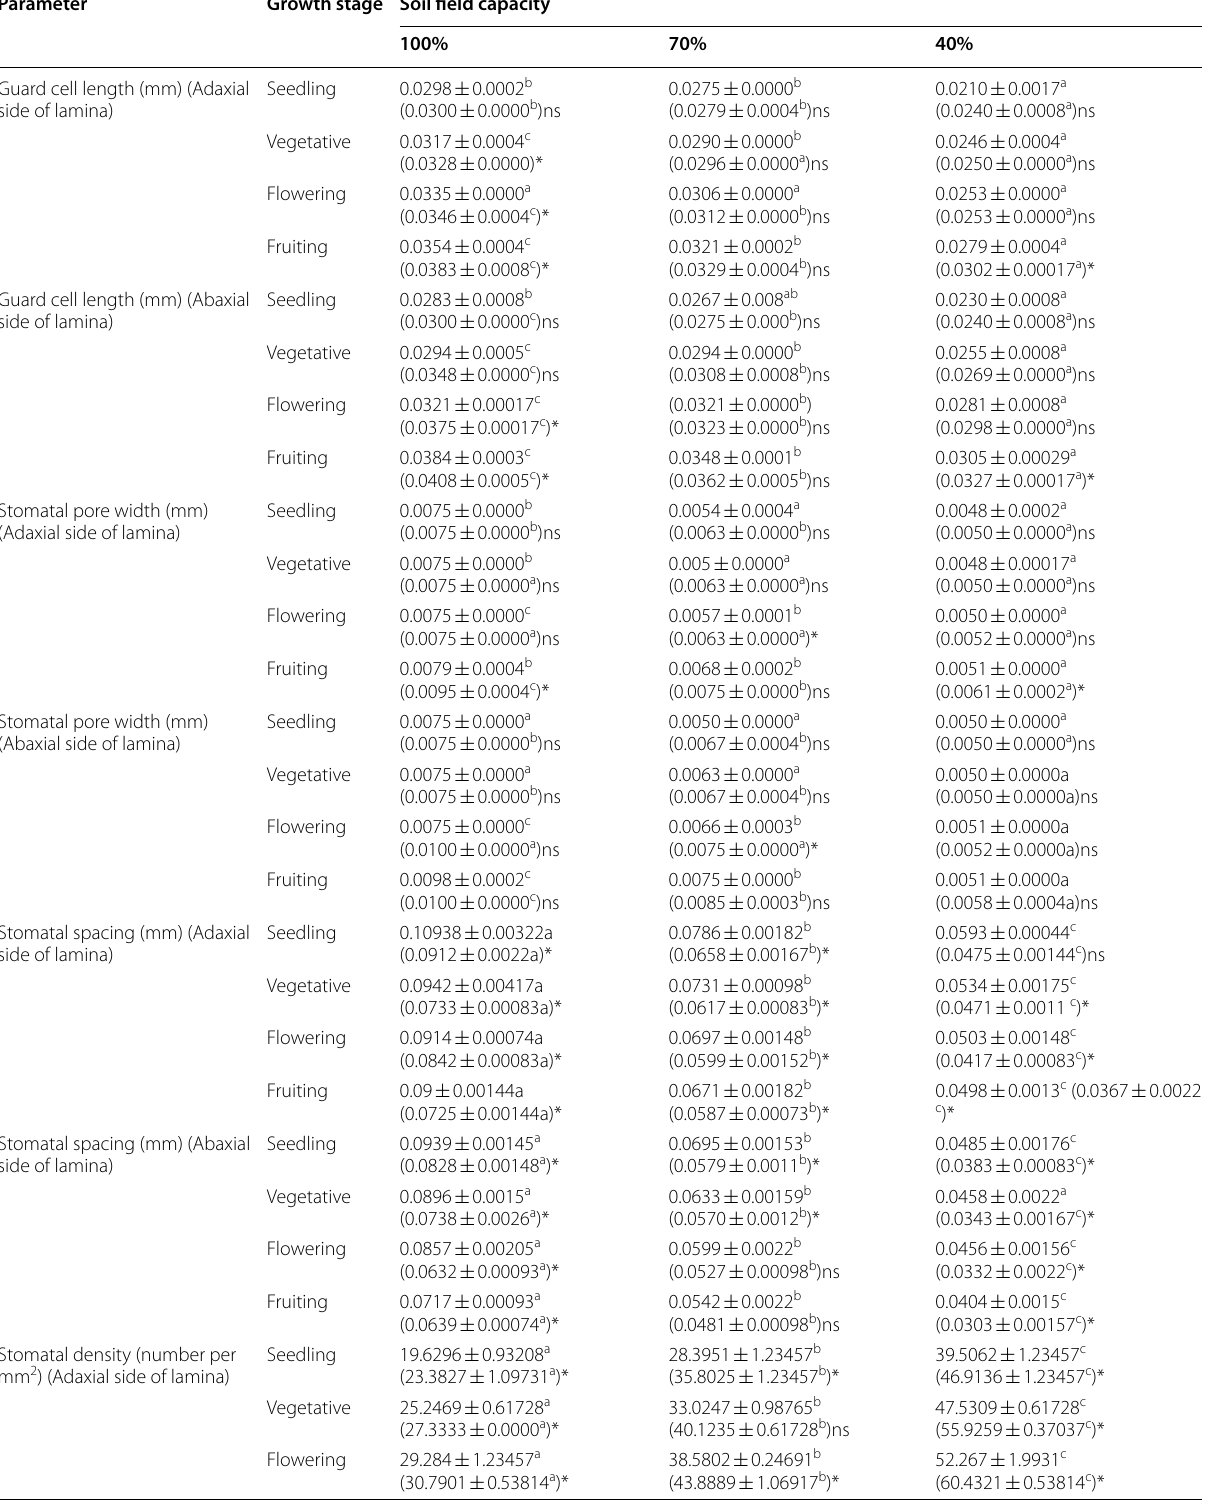
Table 4 One‑way ANOVA of Stomatal Criteria of Ocimum basilicum under Drought and mycorrhiza